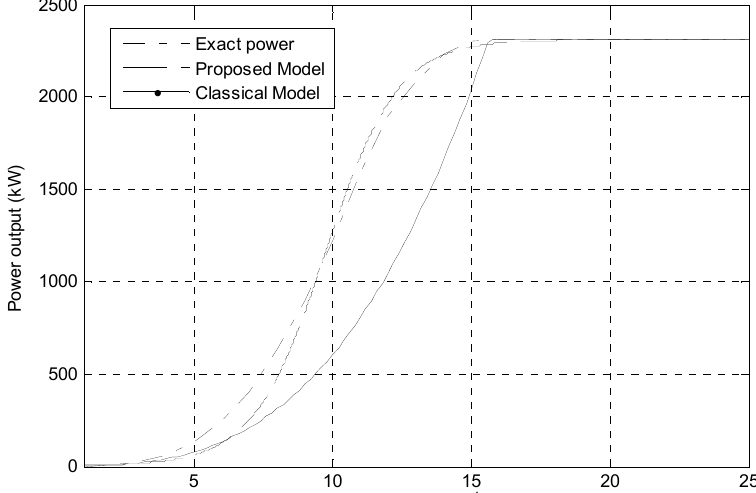
Figure 2. Power characteristic of the ENERCON E70 Wind